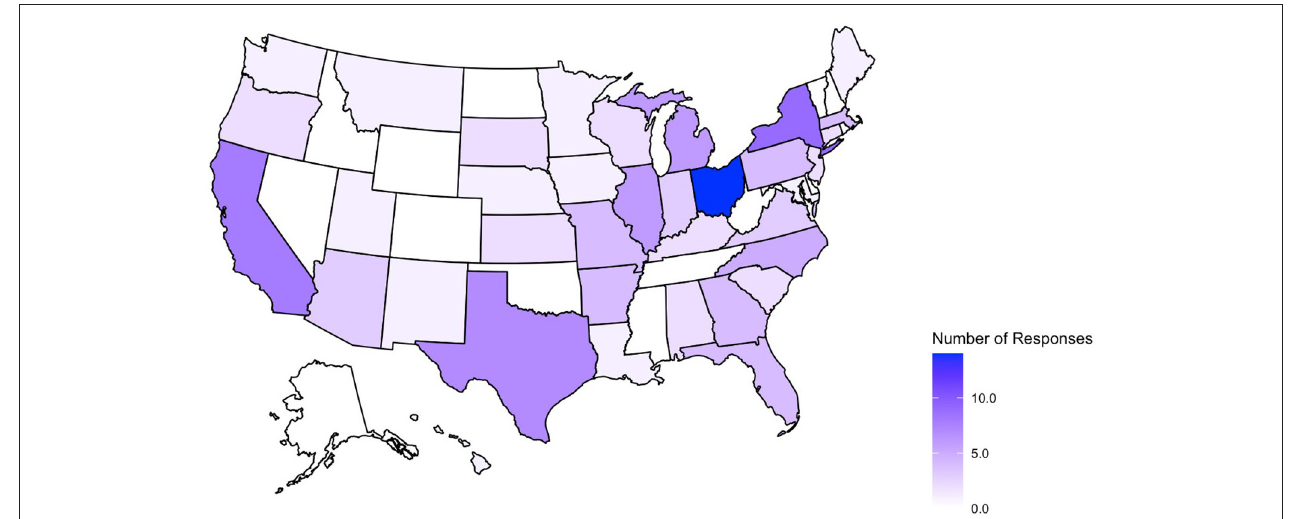
FIGURE 2 | States represented in collected survey responses. No submissions from AK, CO, DE, ID, MS, NV, NH, ND, OK, RI, TN, VT, WV, WY.